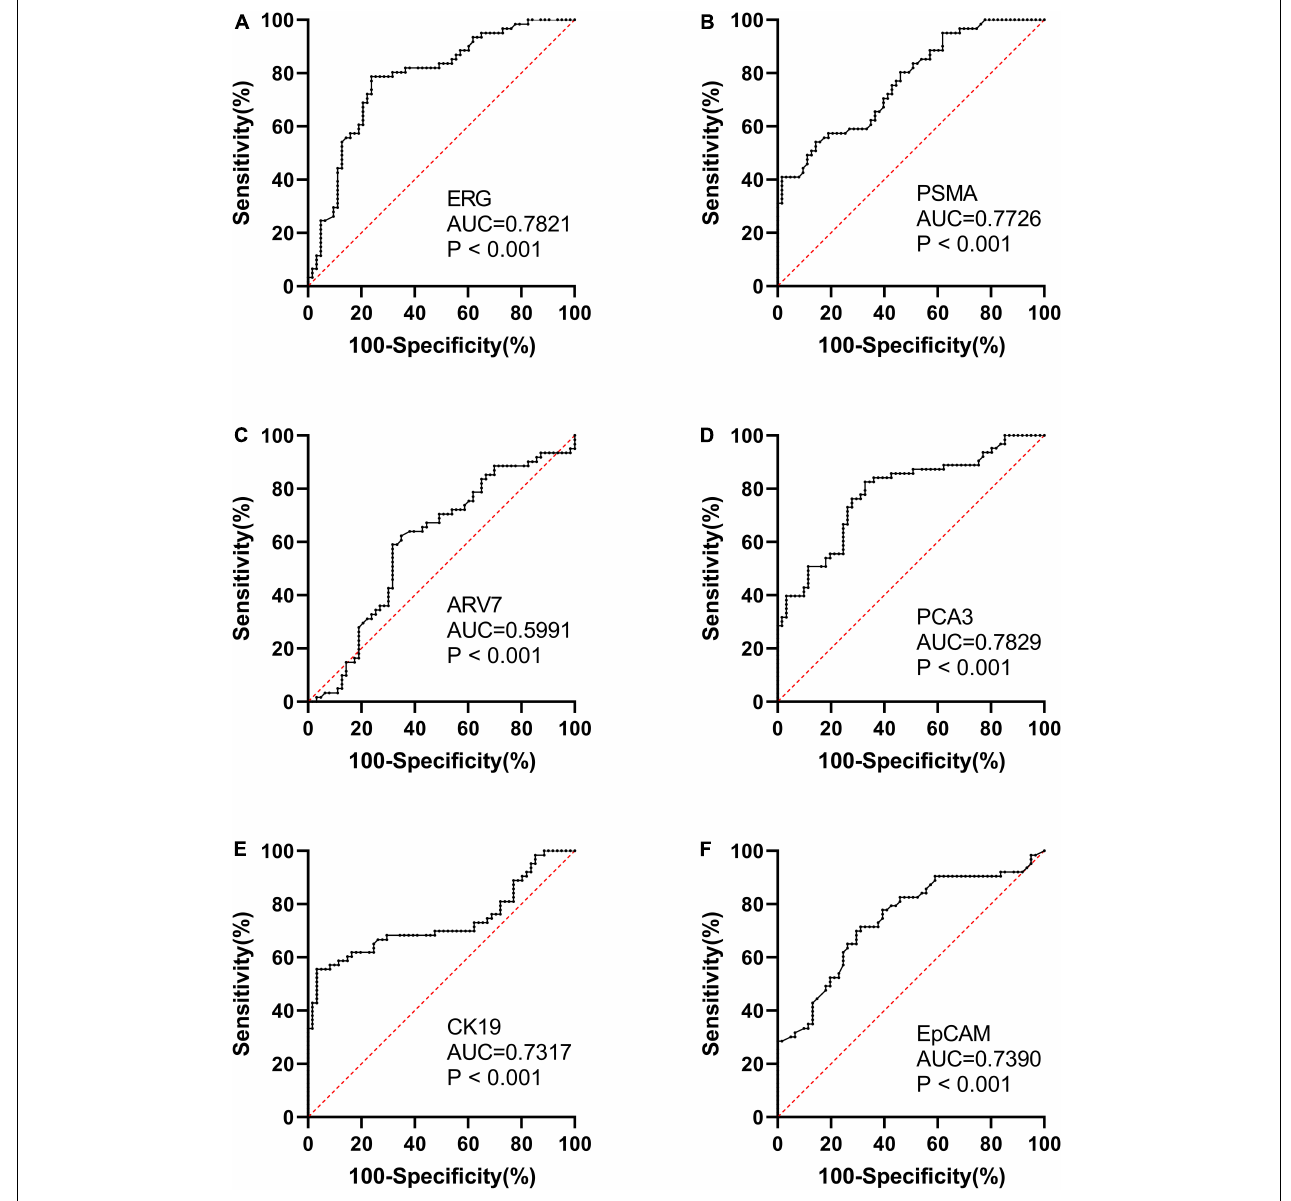
FIGURE 2 | ROC curve analysis and AUC with 95% CIs of mRNAs analyzed in the urinary exosomes of PCa patients ( n = 63) and healthy subjects groups ( n =